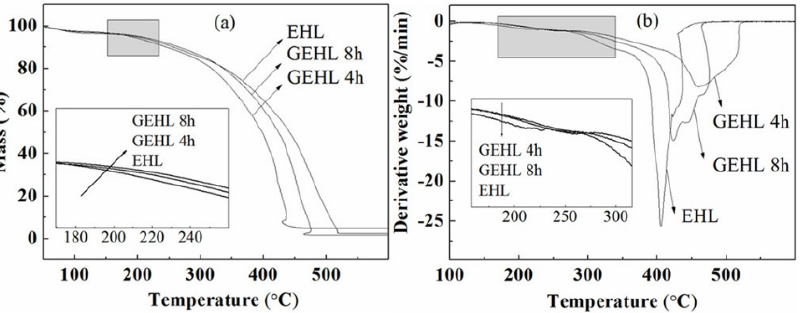
Figure 4. The reaction DSC curves of ( a ) lignin and PAPI, and ( b ) lignin and epichlorohydrin.